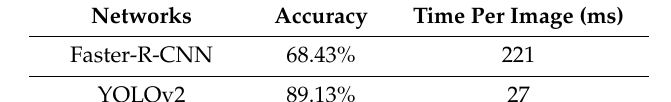
Figure 7. Training average precision for each iteration in class of ship on SSDD. Table 4. Ship Detection Accuracy and Speed Comparison on the DSSDD Dataset.